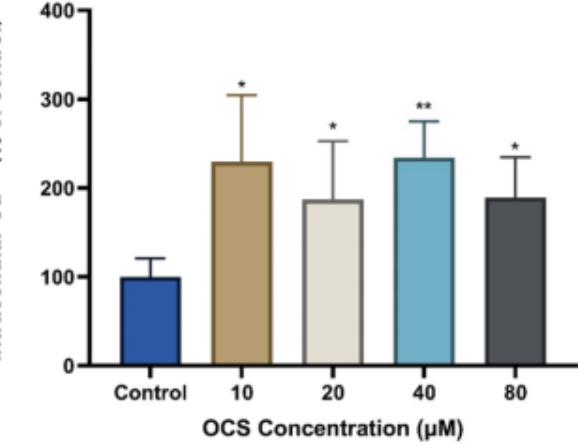
Figure 5. The concentration of intracellular Ca 2+ after treatment with OCS for 24 h in HepG2 cells. Values are mean ± SD of three independent experiments ( n = 3) (* p < 0.05, ** p < 0.001 vs. control).